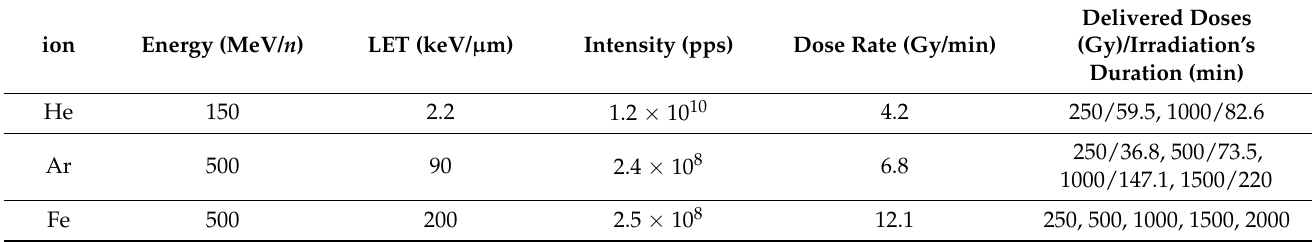
Table 1. HEV ion radiation process parameters.